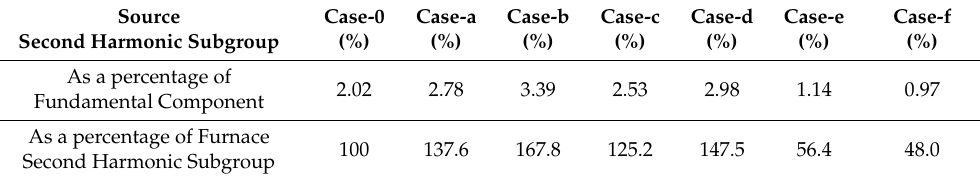
Table 2. Second harmonic subgroup content of the supply line current waveform for different passive shunt harmonic filter bank/s as defined in Table 1 (Case-0 is the no filter case, therefore, I sn = I eafn